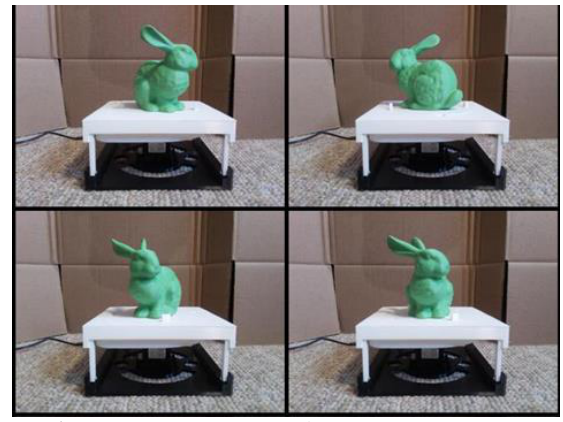
Figure 13. Example images from the third experiment